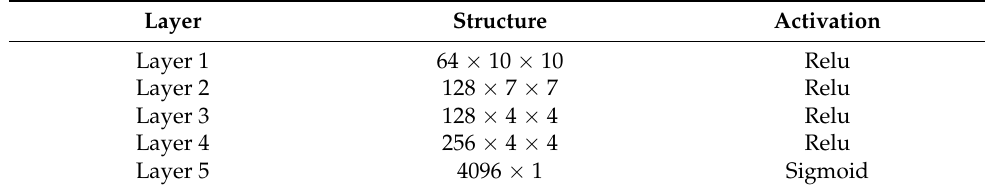
Table 4. Wheel matching network